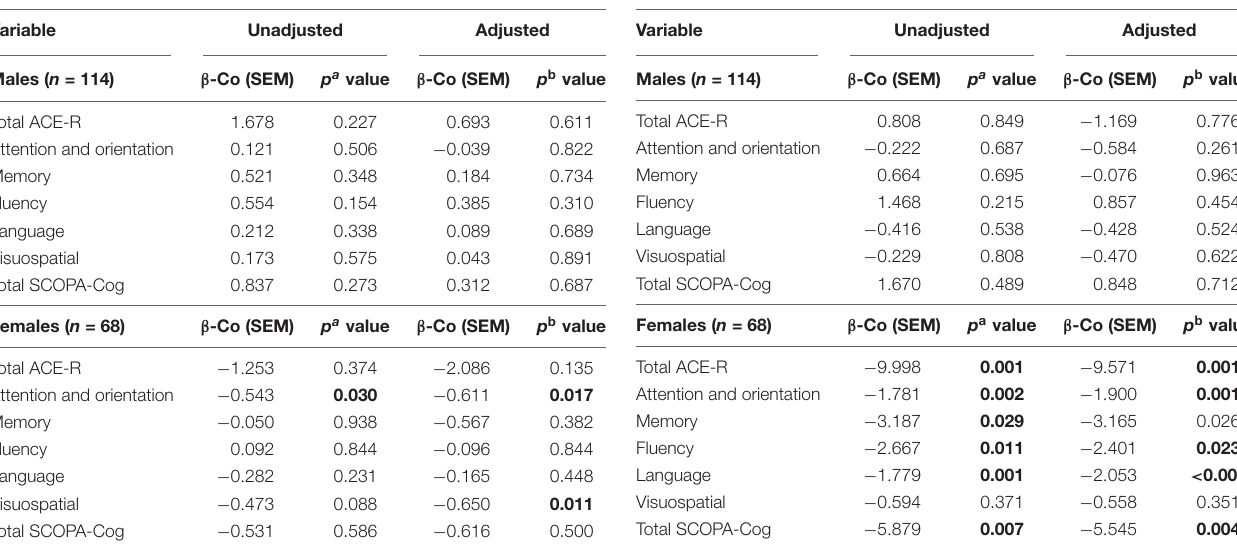
TABLE 4 | Cognitive performance in participants based on HDL levels, when separated by sex.